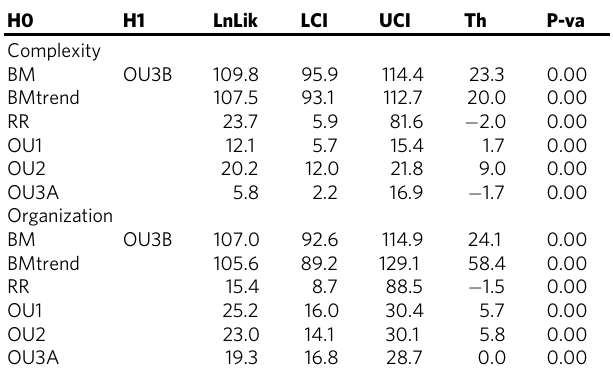
Fig. 5 Hypothesis tests between the functional shift and other models. Based on 1000 simulations for complexity ( a ) and organization ( b ). Top fi gure is an example plot. Red curves represent simulated distribution of Likelihood ratio (LR) under the null model and blue curves represent the simulated distribution under the test model. Vertical line indicates median LR recovered from jackkni fi ng the observed data, with dashed lines indicating their con fi dence intervals. The shaded box represents 97.5% of the simulated null distribution. H0 is rejected in favor of H1 if the observed LR falls outside the signi fi cance threshold based on simulation (shaded box). Source data are provided as a Source Data fi le